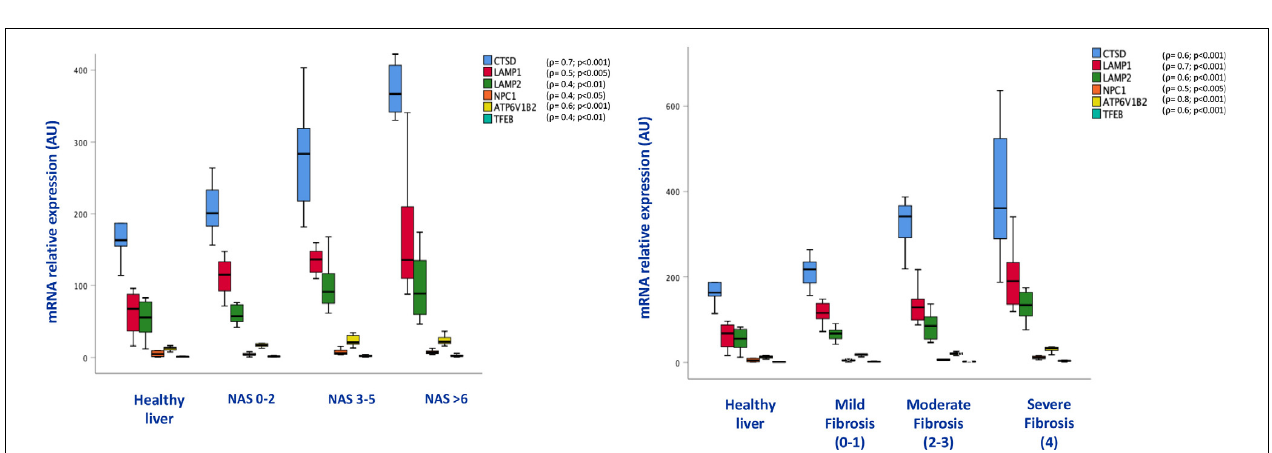
FIGURE 4 | Box plots of mRNA expression of lysosome related genes in association with NAS score (on the left ) and fibrosis stage (on the right ); ( n = 38). For correlation purpose Spearman’s ρ test was